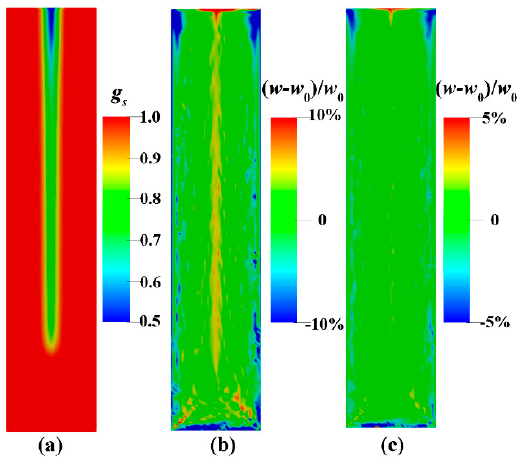
Figure 6. The predicted solid volume fraction ( a ), relative concentrations for C ( b ), and Mn ( c ) in the steel ingot when the top right mold was removed.